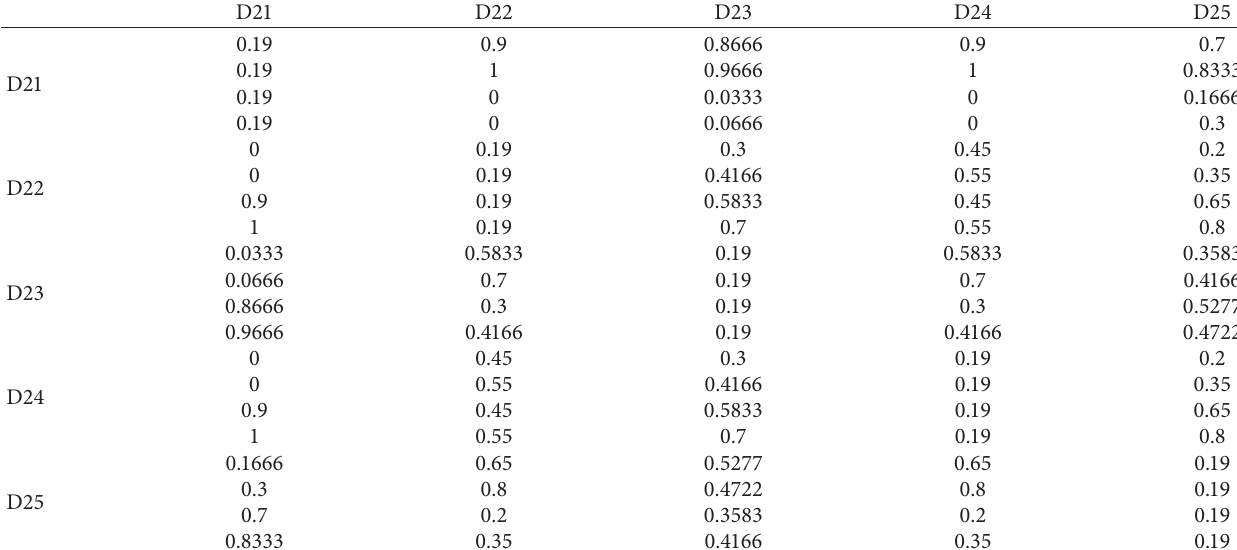
Regression analysis applied, D.W. � 1.83. Table 6: Pairwise comparison of subcriteria according to D2 main